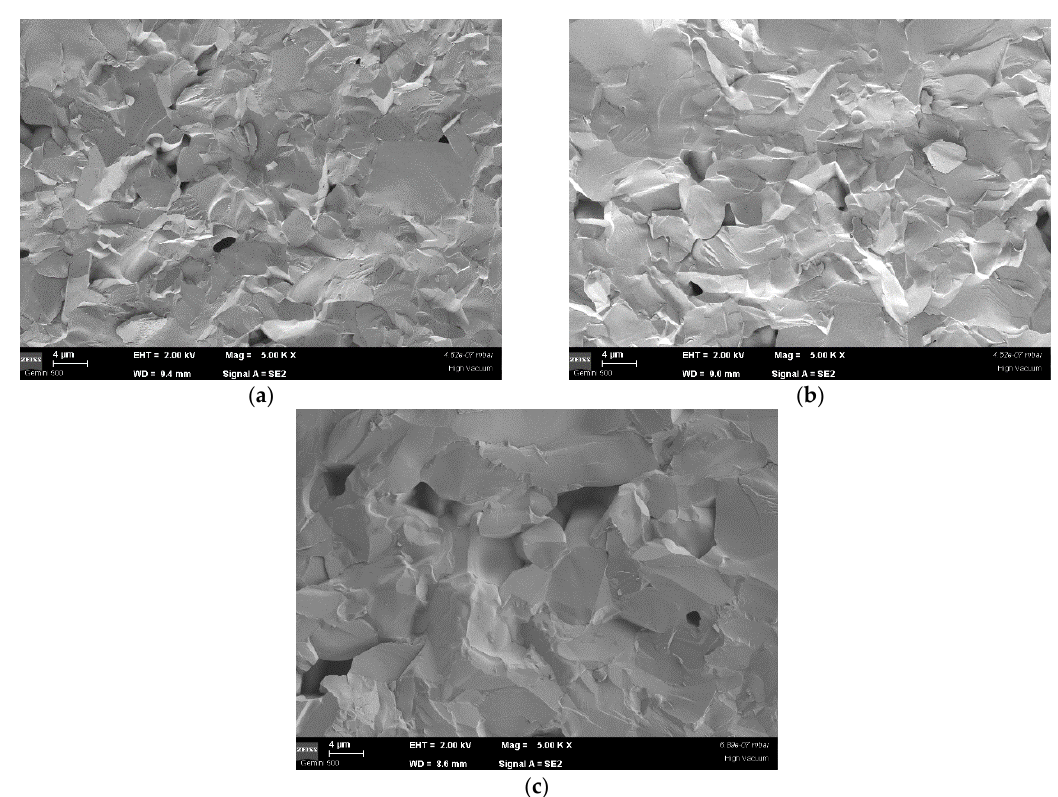
Figure 2. SEM (scanning electron microscopy) micrographs of the ZST samples sintered at ( a ) 1300 ◦ C/2 h, ( b ) 1300 ◦ C/4 h, and ( c ) 1350 ◦ C/4 h. All the images were recorded using an accelerating voltage (EHT) of 2 kV, at working distances (WD) between 8.8 mm and 9.5 mm, and × 5000 magnification. The scale bars have 4 µ